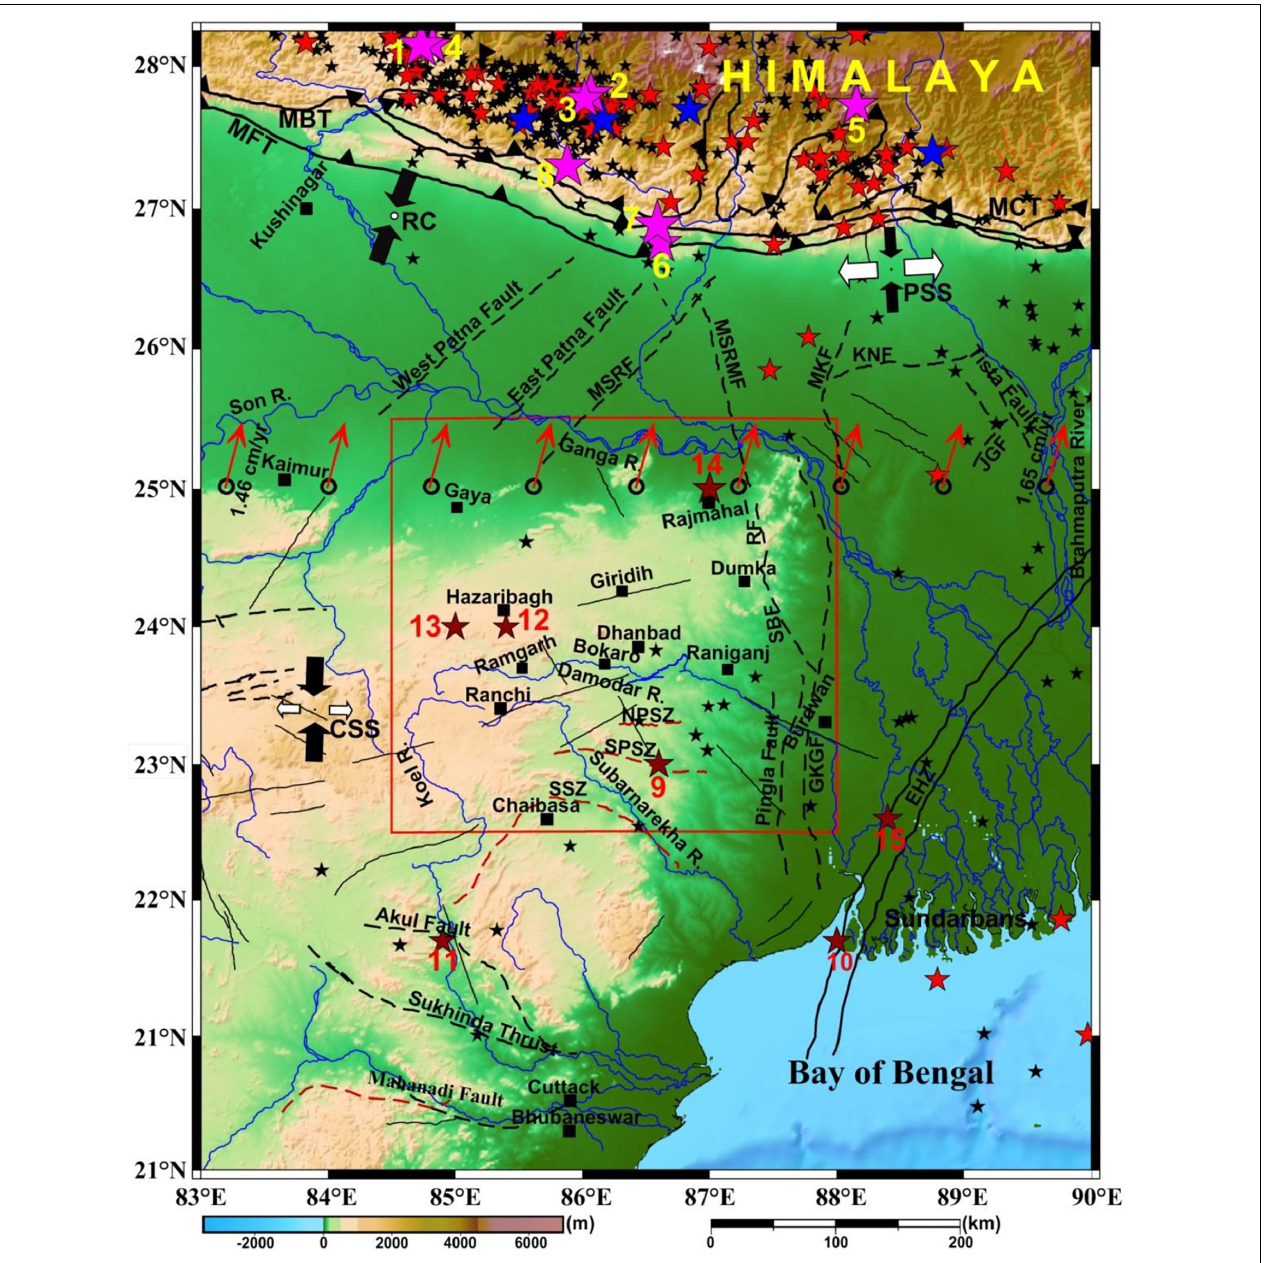
FIGURE 2 | Seismoteconics and topographic relief Map of EIS (EIS) and adjoining regions (after Dasgupta et al., 2000; Singh et al., 2020). The study area is marked by a red rectangular box. Black dashed lines represent faults, and black solid lines denote lineaments. Blue solid lines show the various permanent rivers. Black solid squares represent the locations of a few important areas. A combination of black and white solid arrows shows the stress regimes of that part within shallow depth (0–20 km). RC, radial compression; PSS, pure strike-slip; CSS, compressive strike-slip. Red arrows represent the Indian plate velocity motion direction with respect to the Eurasian plate. All stars show the seismicity since 1973 to May 2020 (from USGS Catalog). Magenta stars show the location of damaging earthquakes with magnitudes of 6.5 < M ≤ 8.0 (1: 2015 M 7.8 Nepal, 2: 2015 M 7.3 Nepal, 3: 2015 M 6.7 Nepal, 4 2015 M 6.6 Nepal 5: 2011 M 6.9 Sikkim, 6: 1988 M